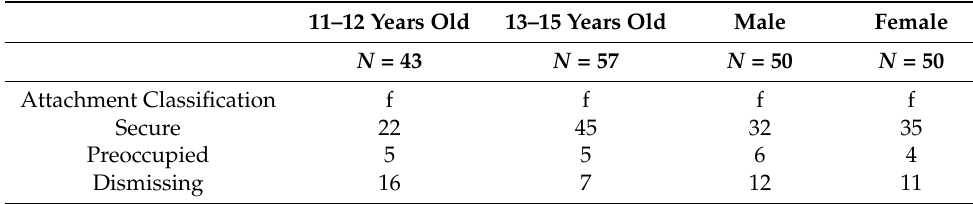
Table 2. Attachment classification: sex and age